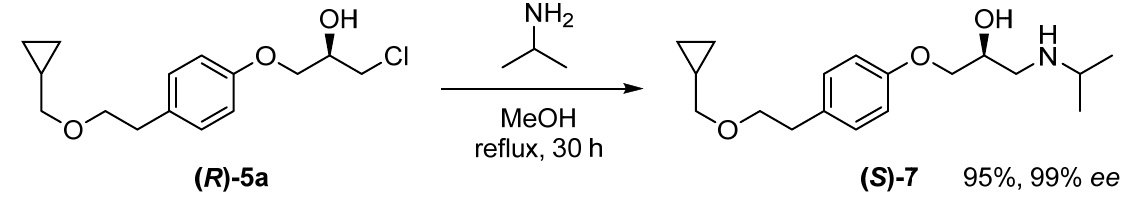
Scheme 5. Synthesis of ( S )-betaxolol (( S )- 7 ) in 95% yield and 99% ee by amination of chlorohydrin ( R )- 5a (99% ee ) with isopropylamine in methanol. Table 1. E -values, ee -values and specific rotations of the enantiopure chlorohydrins ( R )- 5a and ( R )- 5b , ester ( S )- 6a and the drug ( S )- 7 . Specific rotations were determined at 20 ◦ C in CHCl 3 . For additional parameters, see Section 3. For spectra and chromatograms, see Supplementary Materials. Enantiomer E -Value Specific Rotation, ee